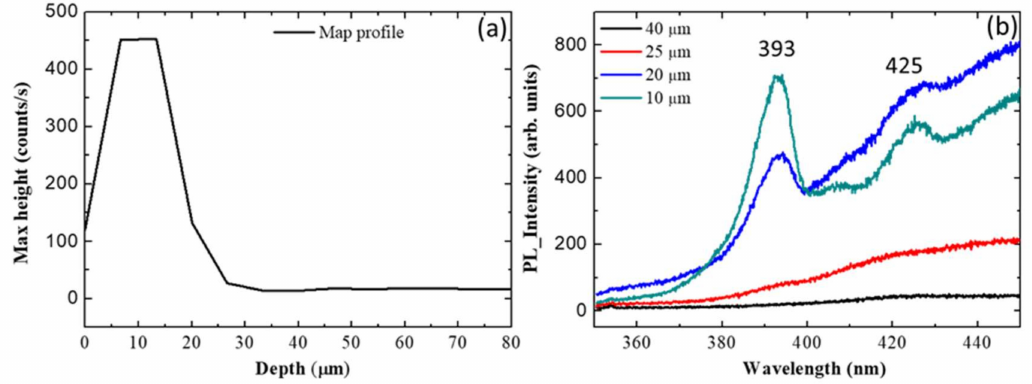
Figure 5. ( a ) Profile µ -PL linear map at 390 nm and ( b ) spectra extracted at various thicknesses. The point 0 on the X axis (in left panel) indicates the original silicon